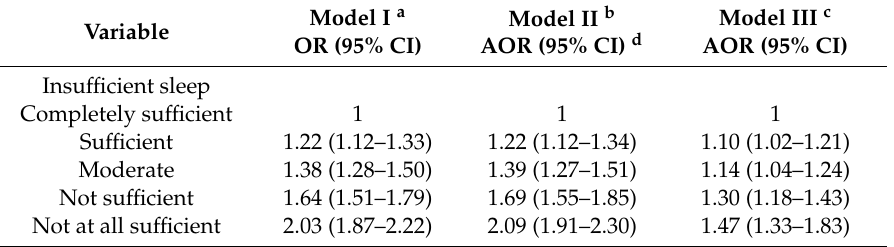
Table 3. Logistic regression analysis for association between insu ffi cient sleep and bad